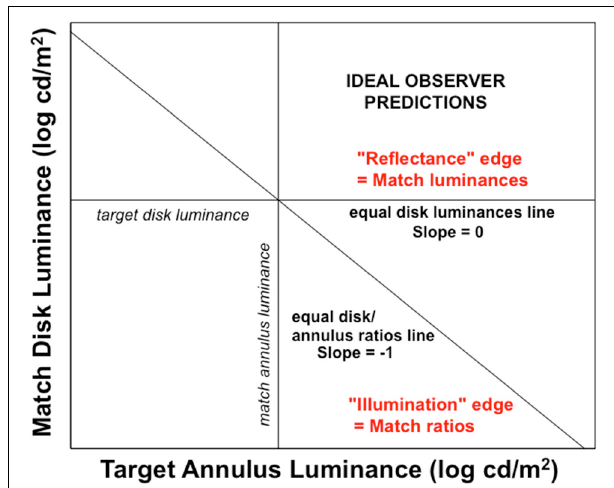
FIGURE 7 | Ideal observer predictions for lightness matching in a disk-annulus display under two different assumptions about the nature of the illuminant. When the luminance step at the outer edge of the annulus is judged to be the result of a change in surface reflectance, it will ideally contribute to an edge integration computation of lightness (perceived reflectance). The goal of such a computation is to veridically relate the target disk reflectance to the reflectance of the background field and, by extension, to the reflectance of another, matching, disk, viewed against the same background. The computation is carried out by spatially integrating the two luminance steps. Since no illumination variation is assumed, both disks are implicitly assumed to be viewed under the same illumination conditions and a reflectance match corresponds to a luminance match. When the luminance step at the outer edge of the annulus is judged to be the result of an illumination change, on the other hand, the luminance step at the outer annulus edge should not be included in a computation that seeks to relate the disk reflectance to that of the background field. In this case, the “annulus” is interpreted to be a differently illuminated region of the background field and not a separate surface with a different reflectance, The disk lightness can thus be related to the background by computing the disk/annulus luminance ratio—in log units, the step in log luminance at the disk/annulus edge, alone. The luminance matching and ratio matching predictions corresponding to the two interpretations in which the outer annulus edge is either seen as a reflectance edge or illumination edge are indicated by straight lines with slopes of 0 and -1, respectively, on this log-log plot.